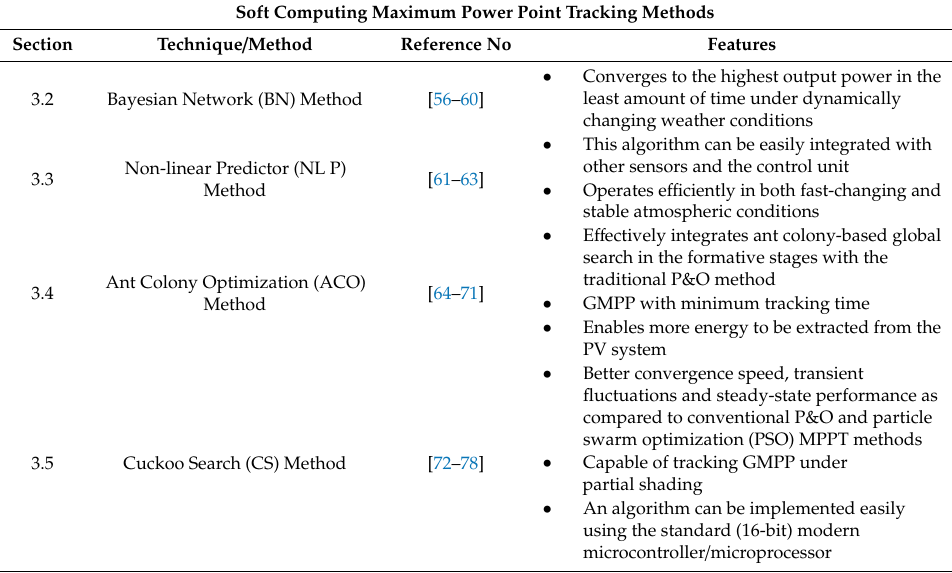
Table 5. Features of soft computing maximum power point tracking